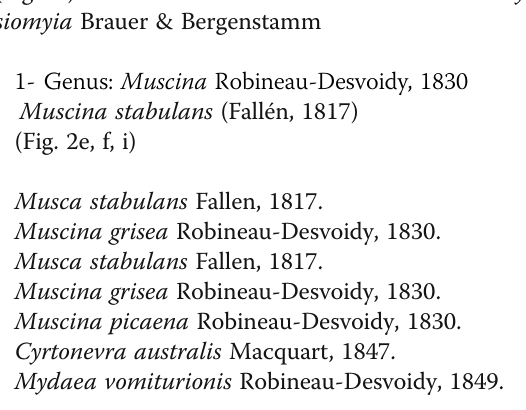
Body about 7 – 10 mm in length, grayish in color. Antennae and palpi bright yellow orange in color; arista bare. Thorax striped; posterior spiracles with S-shaped slits; episternum without cilia; hypopleural bristles ab- sent. Apical part of vein M strongly curved forward. Abdomen gray with a patterns resembling checkerboard and somewhat tessellated with yellow color at